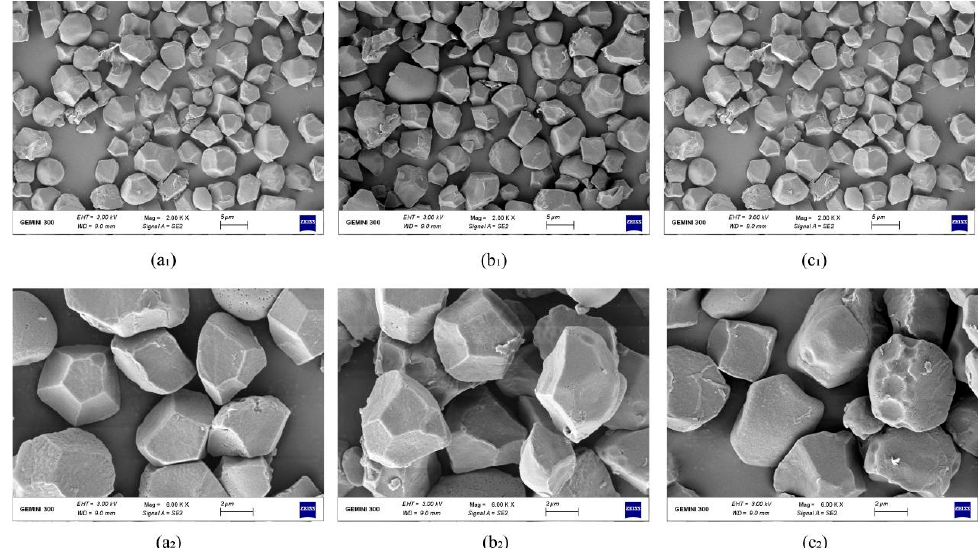
Figure 2. Scanning electron microscope photos of rice starch granules with different storage times; ( a1 , a2 ) are starch granules under storage year-0 2K, 6K lens; ( b1 , b2 ) are starch granules under storage year-1 2K, 6K lens; ( c1 , c2 ) are starch granules under storage year-2 2K, 6K lens. Table 2. Order degree of rice starch from different storage time.